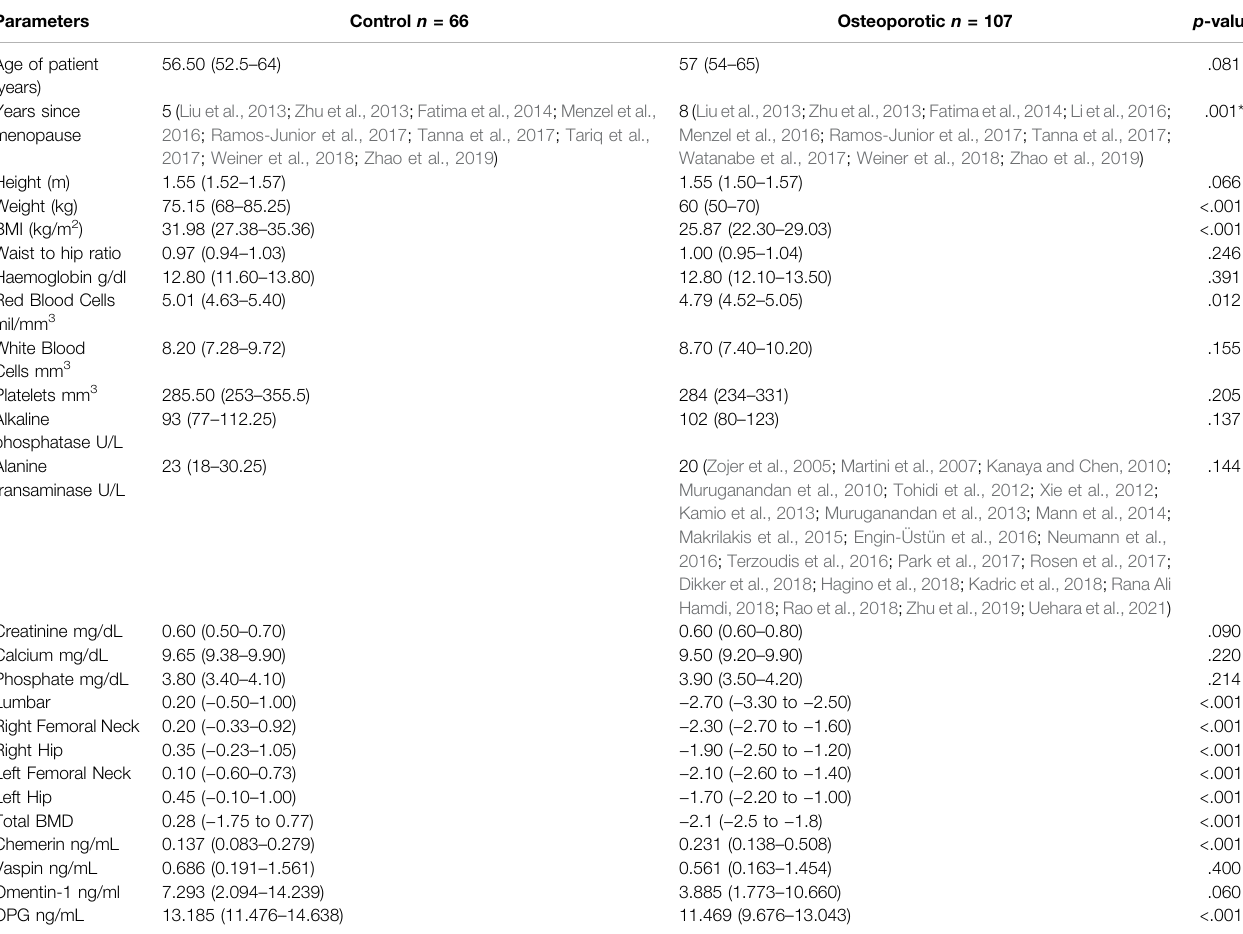
TABLE 1 | General characteristics and biochemical parameters of the study